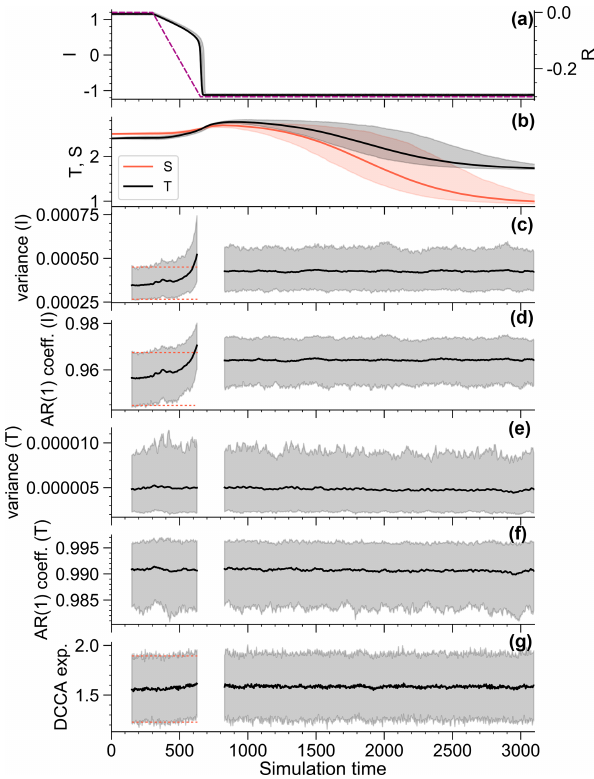
Figure 12. Ensemble simulations of the coupled sea ice ocean model, where R is ramped linearly from R = 0 to R = − 0 . 3 within 350 years. (a) Time series of R (dashed line) and mean time series of I with a 90% confidence band of the ensemble (gray shading). (b) Mean time series and 90% confidence band of T and S . (c– f) Indicators of critical slowing down for I and T , estimated in a sliding window of 150 years, where the data in the window is de- trended by a cubic function. The data is cut as the bifurcation in I is crossed until after the last realization tips plus the sliding window length. (g) Detrended cross-correlation analysis (DCCA) exponent estimated from I and T